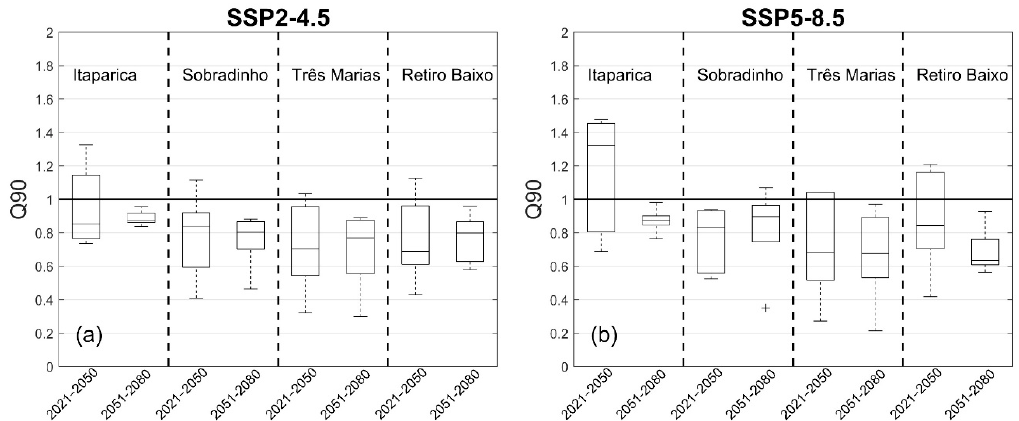
Figure 10. Ratio between the flow rate: ( a ) with 90% duration of the future scenario models SSP2-4.5 (2021–2050 and 2051– 2080) and the flow rate with 90% duration of the control period of the Historical models (1901–2000) and ( b ) with 90% duration of the future scenario models SSP5-8.5 (2021–2050 and 2051–2080) and the flow rate with 90% duration of the control period of the Historical models (1901–2000). The continuous horizontal line represents the situation without future change, with a ratio equal to 1.